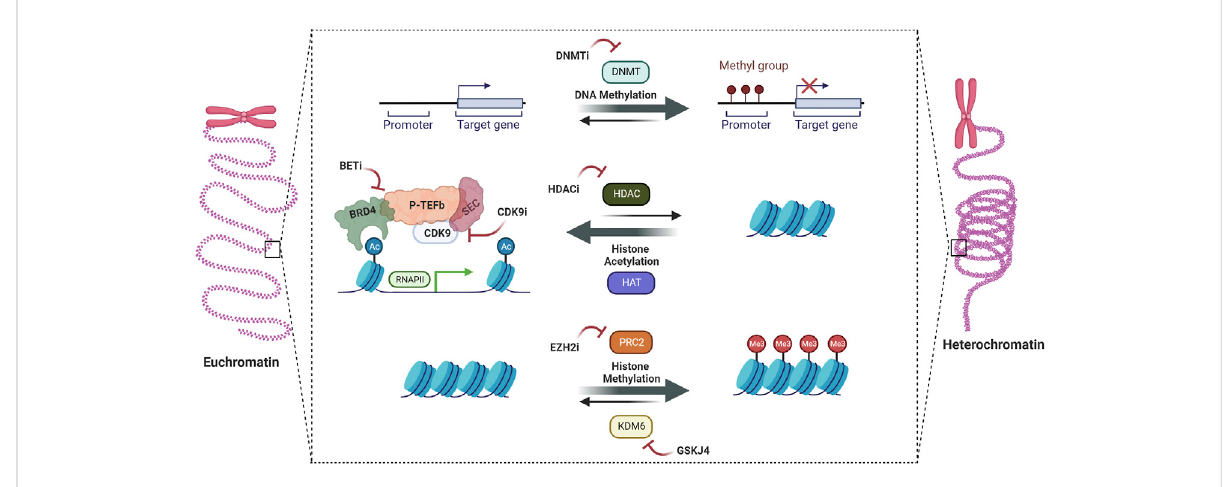
FIGURE 1 Epigenetic therapies in pediatric high-grade